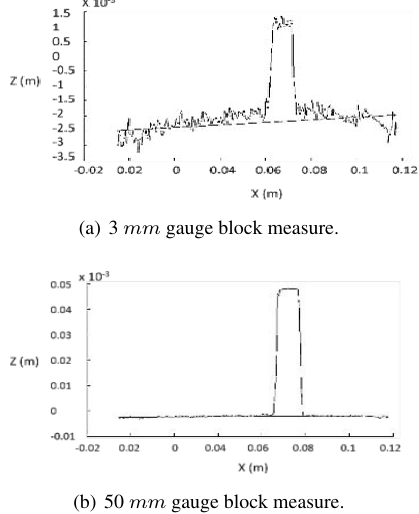
Figure 5. 2D reconstructions of gauge blocks using